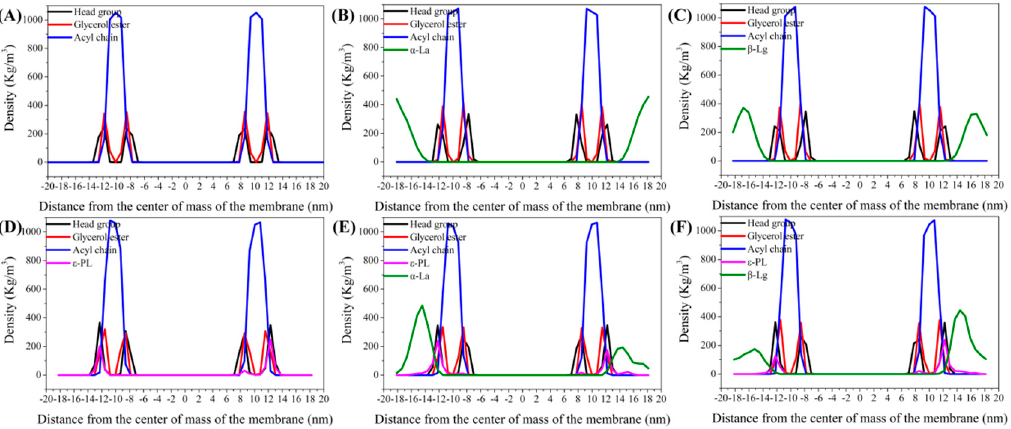
Figure 6. The Z -axis density distribution curve of the components in the interaction of the ε -PL, whey protein, and the whey protein- ε -PL complexes with the Gram-positive bacteria double membrane model. ( A ) POPE/POPG. ( B ) α -La-POPE/POPG. ( C ) β -Lg-POPE/POPG. ( D ) ε -PL-POPE/POPG. ( E ) ε -PL- α -La-POPE/POPG. ( F ) ε -PL- β -Lg-POPE/POPG.